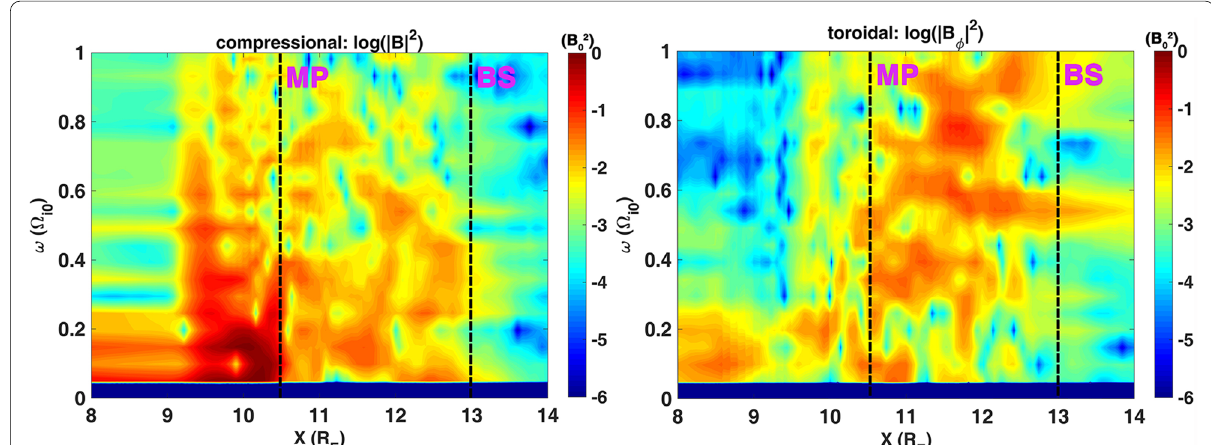
Fig. 4 Case I: power spectra of the compressional and toroidal components from the foreshock into the magnetosphere as a function of X along the Sun–Earth line. Note that the spectrum of the self-consistently generated foreshock waves covers a wide frequency range including The average bow shock and magnetopause positions are marked by the vertical dashed lines